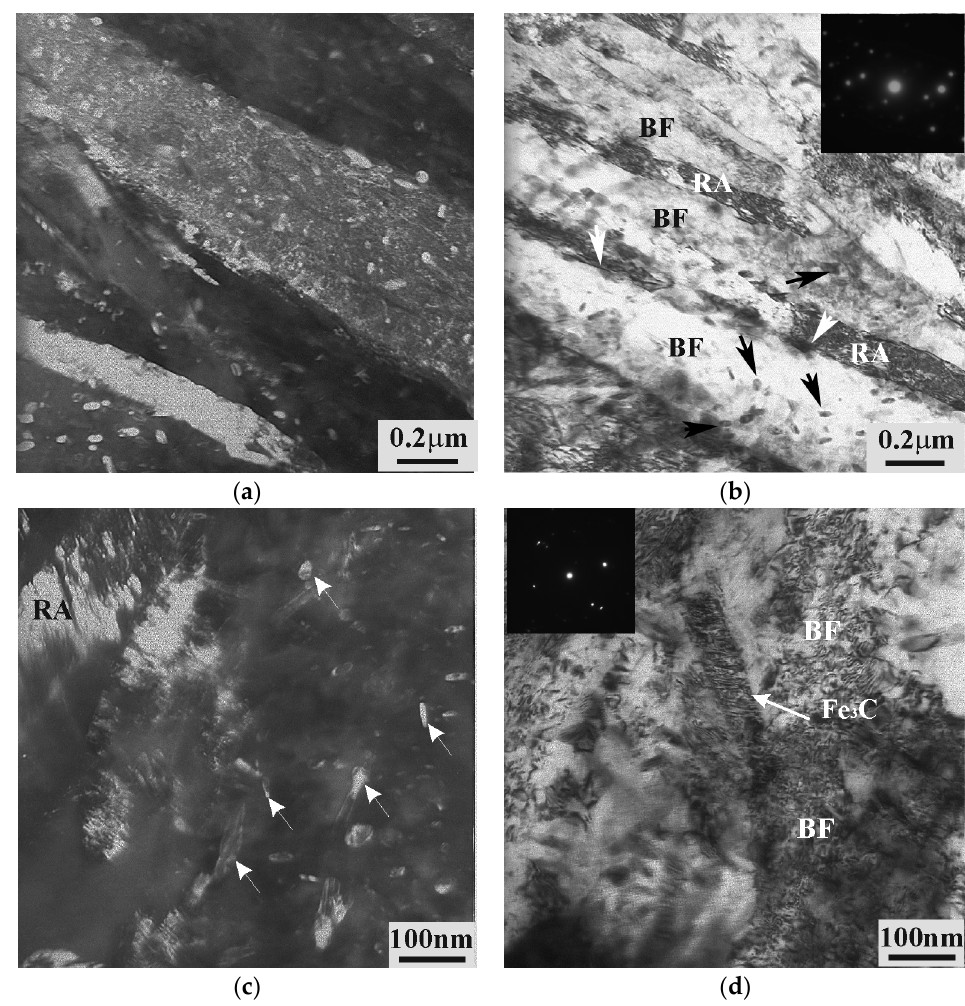
Figure 4. Bright ( a , c ) and dark ( b , d ) TEM images of the bainite core microstructure formed after nitrocarburising at 525 °C for 4 h in ‘200’ ( a , b ) and ‘350’ ( c , d ) bainite: ( a , b ) formation of spherical carbides in bainitic ferrite (dark arrows) and decomposition of retained austenite (white arrows), ( c ) decomposition of the retained austenite with formation of lenticular carbides (white arrow) and ( d ) spherical carbides in the bainitic ferrite.